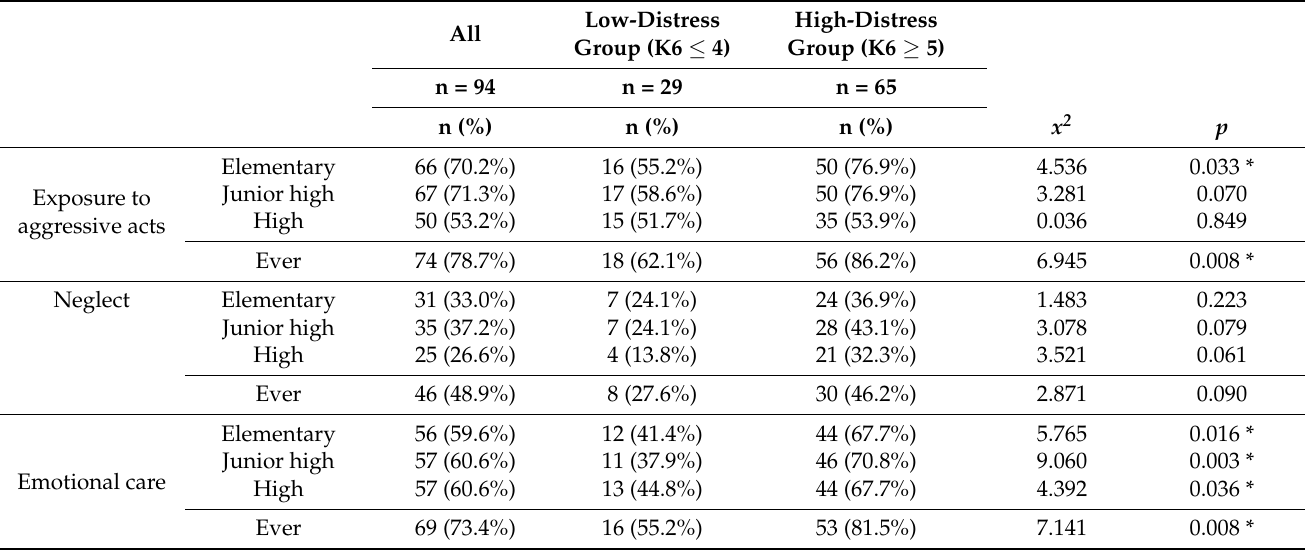
Table 2. Adverse experiences in childhood in the high- and low-distress